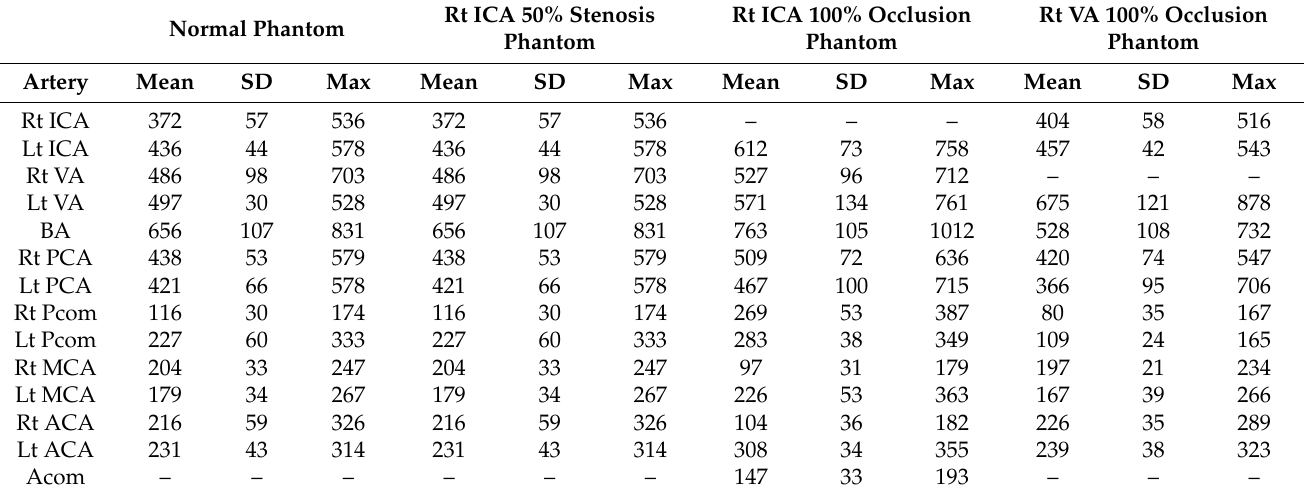
Figure 8. Velocity changes in each vessel of the cerebrovascular disease phantoms compared to the normal phantom: ( a ) right ICA 50% stenosis phantom (ICA50); ( b ) right ICA 100% occlusion phantom (ICA100); and ( c ) right VA 100% occlusion phantom (VA100). The red arrows indicate the same flow direction as the normal model and the blue arrow indicates a reversed flow direction compared to the normal model. Table 2. Average signal intensities in the cerebral vessels of each phantom, corresponding to